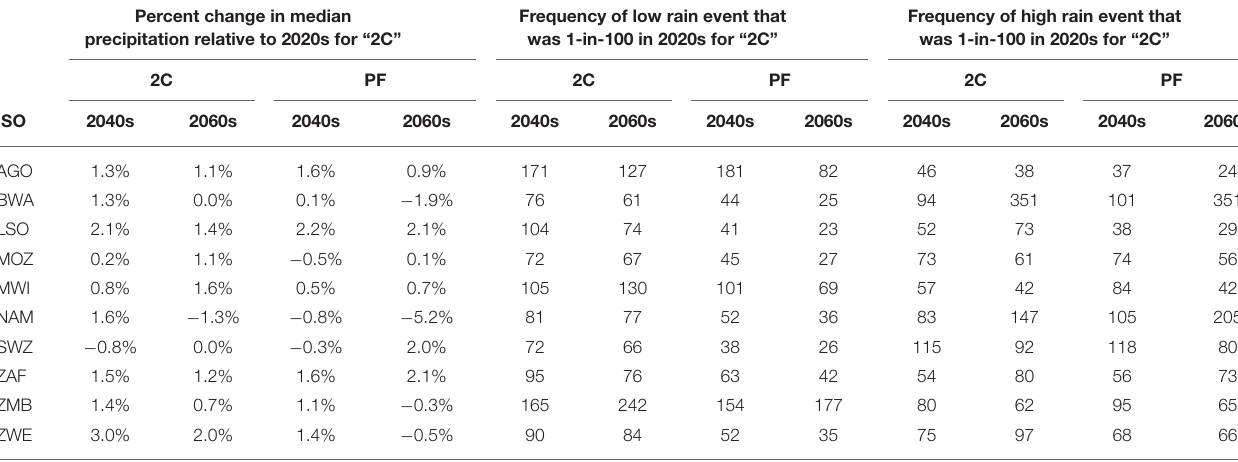
Frequency of low rain event that was 1-in-100 in 2020s for “2C”